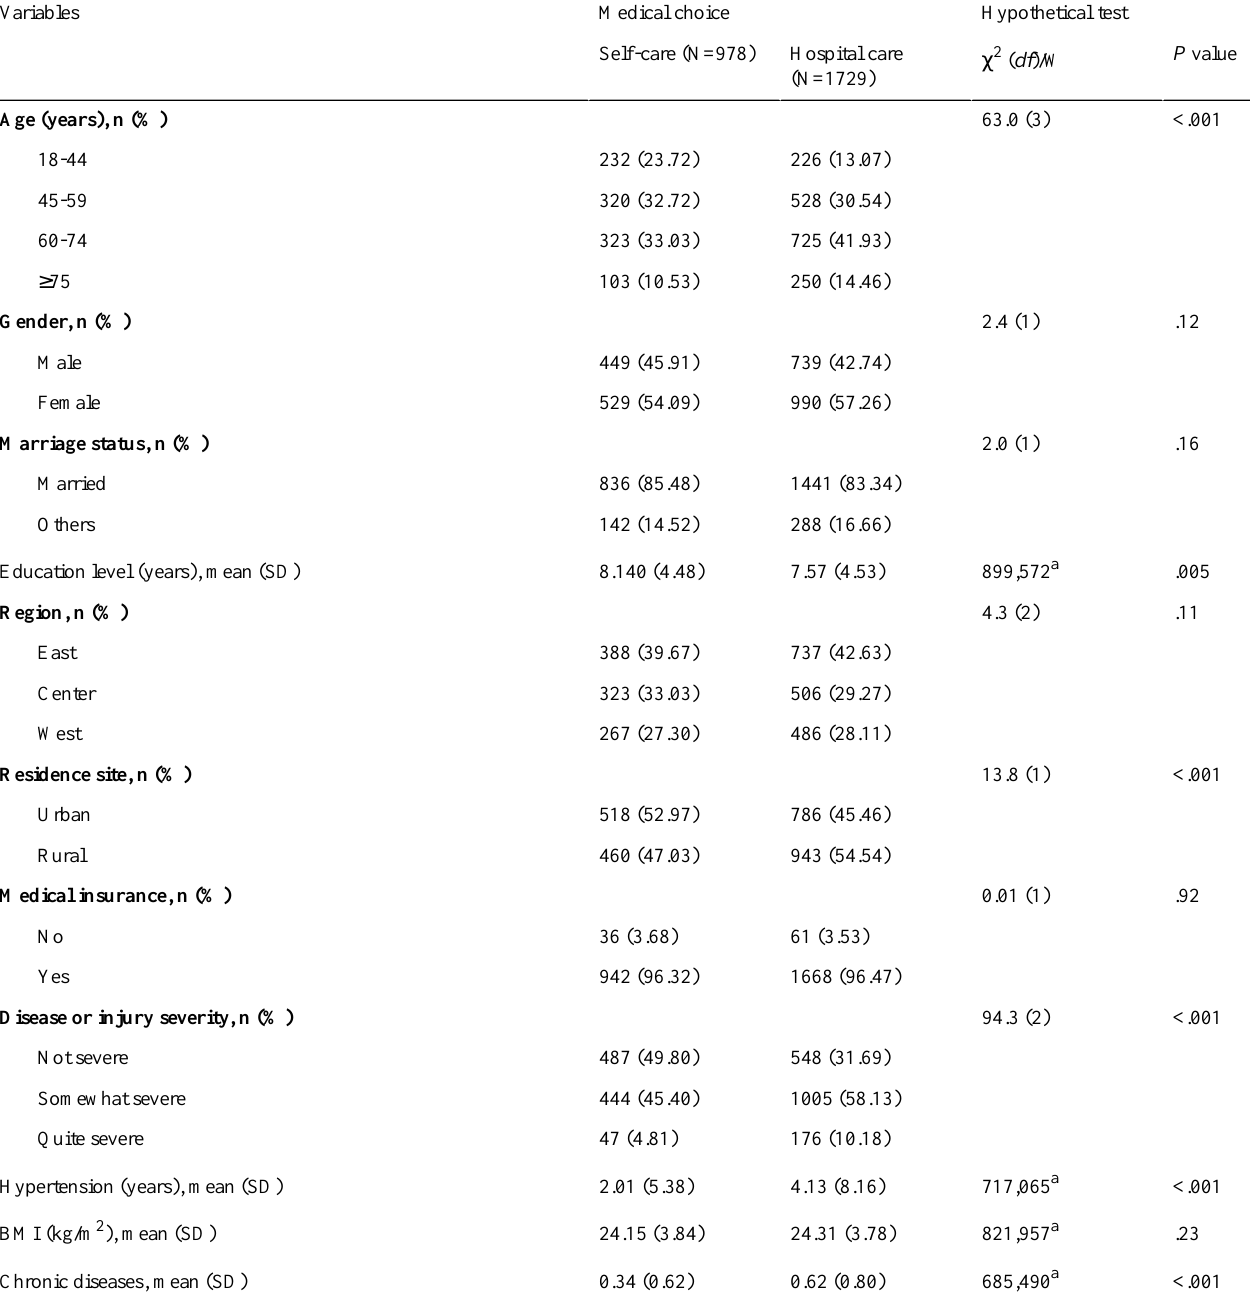
Table 2. Medical choices for people with different characteristics in 2015 (N=2707).